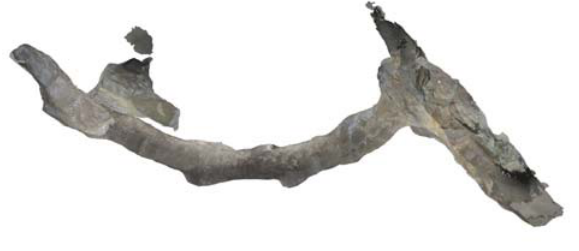
Figure 7. Gallery counter excavated from both ends by fire-setting and by hammer and chisel